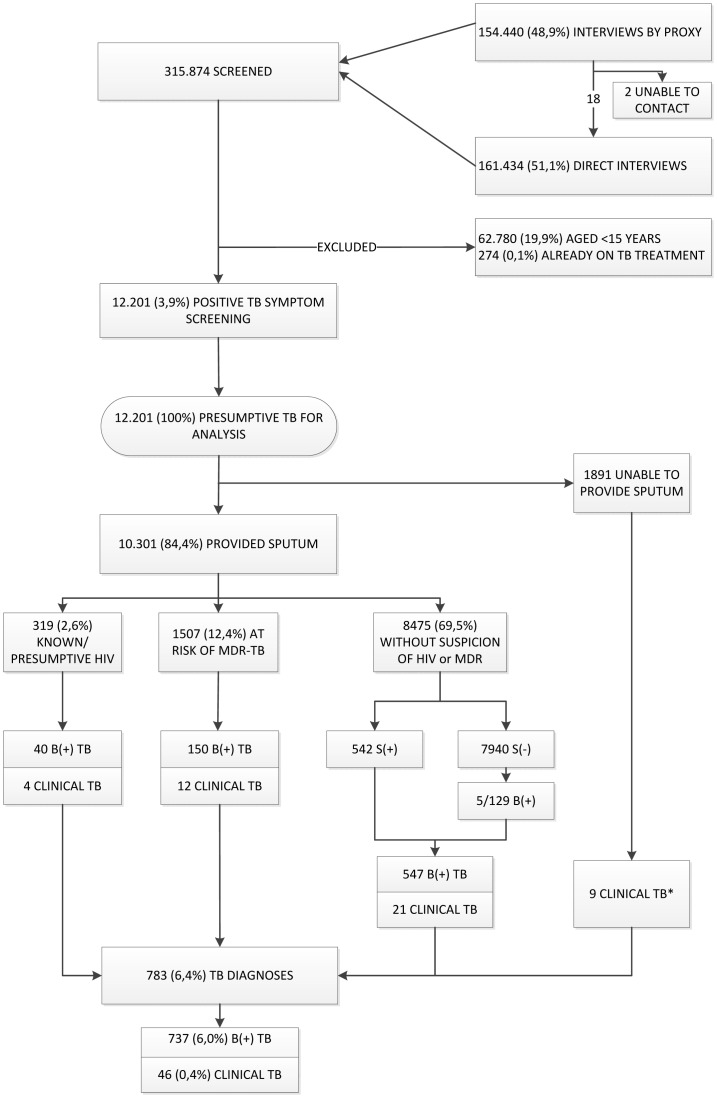
Study flow and tuberculosis yield for the different subgroups.Individuals not screened directly were screened verbally through a proxy. Presumptive tuberculosis indicates a positive symptom screen (any cough, fever, night sweats, weight loss or hemoptysis). *Of the patients who did not provide sputum, 2/114 patients at risk of MDR-TB were diagnosed with clinical TB (one with extra-pulmonary TB and one non-confirmed pulmonary TB), and 7/1.737 patients without risk for HIV-associated or MDR-TB were diagnosed with extra-pulmonary TB. HIV: human immunodeficiency virus; MDR-TB: multidrug-resistant tuberculosis; S(+): smear-positive; B(+): bacteriologically-positive; TB: tuberculosis.